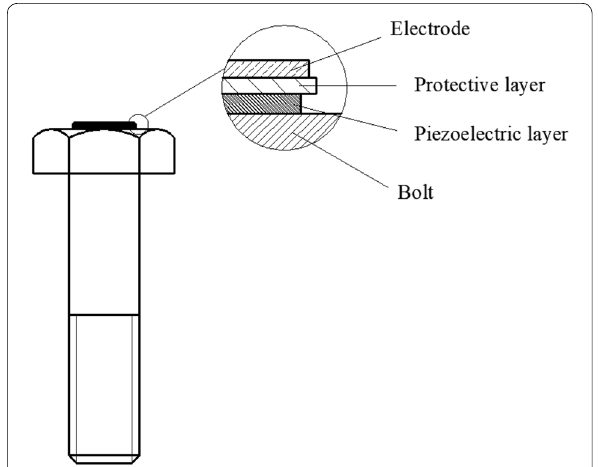
Figure 18 Structure of a piezoelectric sensing bolt